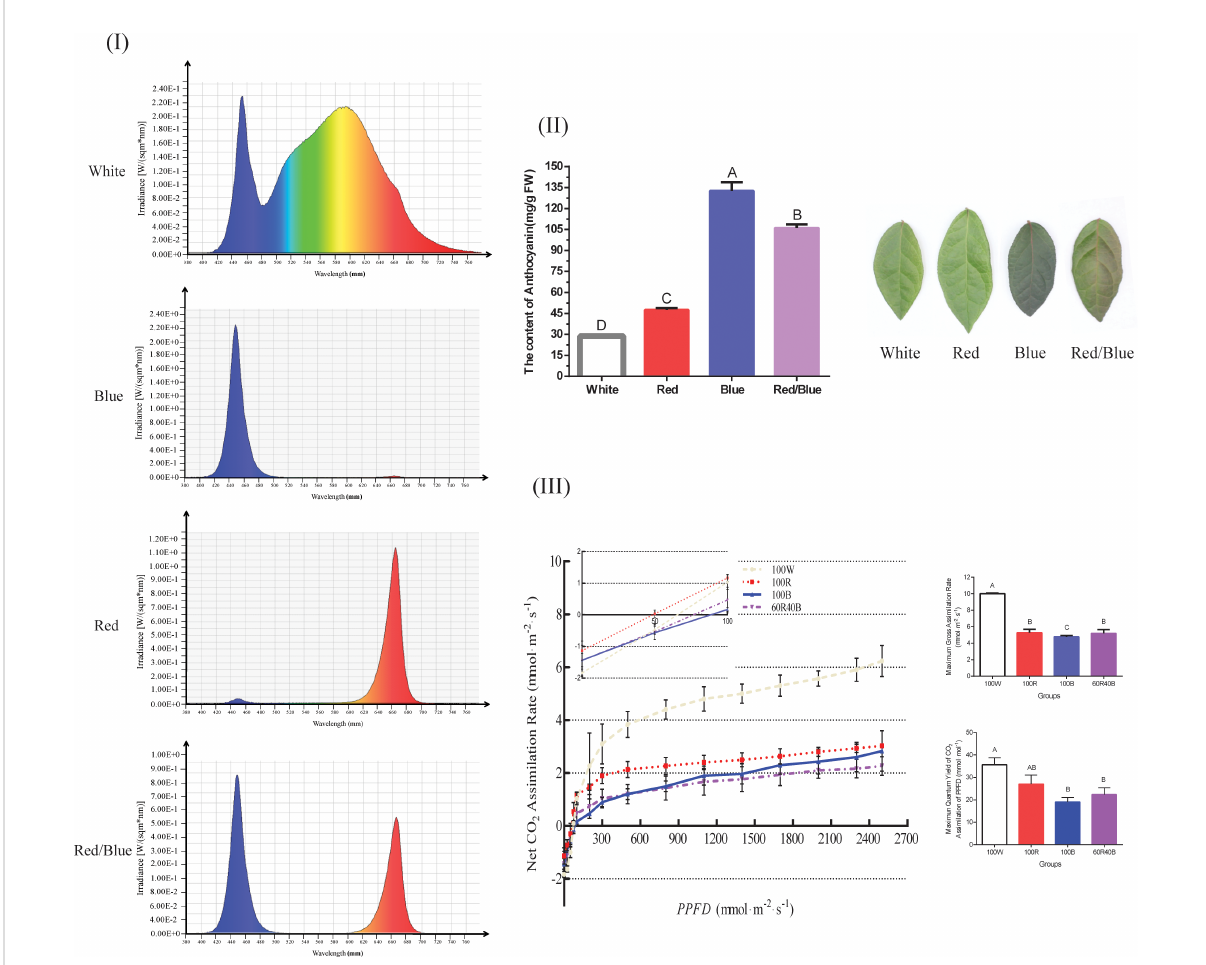
FIGURE 1 Spectrum plot showing the different light qualities and anthocyanin content, light response curves, and photosynthesis of blueberry leaves under four light spectra. (I) Dynamic distributions of the relative spectra under different wavelengths; (II) Anthocyanin content and phenotypic comparisons of blueberry leaves under four light spectra; (III) Net assimilation ( A n)-light response curves, A g, max , and QY m, inc for blueberry leaves under different light spectra. A g, max, maximum gross assimilation rate; QY m, inc , maximum quantum yield of CO 2 assimilation; Capital letters indicate signi fi cant differences at P < 0.01 among the different treatments. Error bars indicate the standard deviation based on three